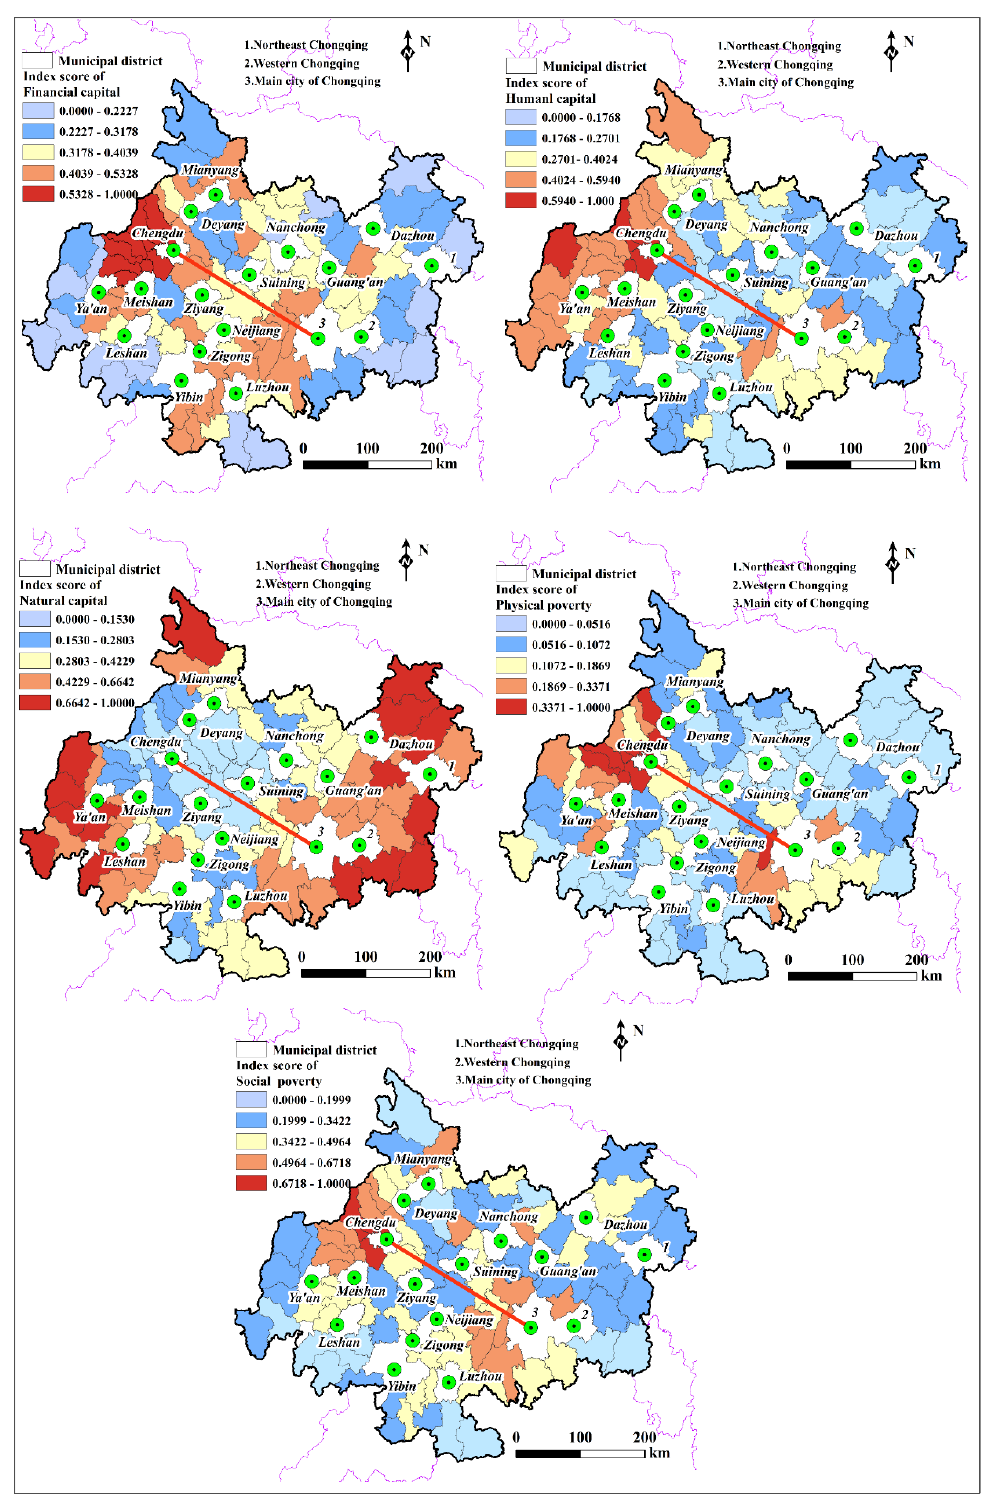
Figure 6. The normalized composite scores of each dimension in the Chengdu-Chongqing Economic Zone in 2020. Notes: The scores of each dimension were calculated based on the data shown in Section 2.2 and the weights shown in Table 4. The figure shows the standardized scores.